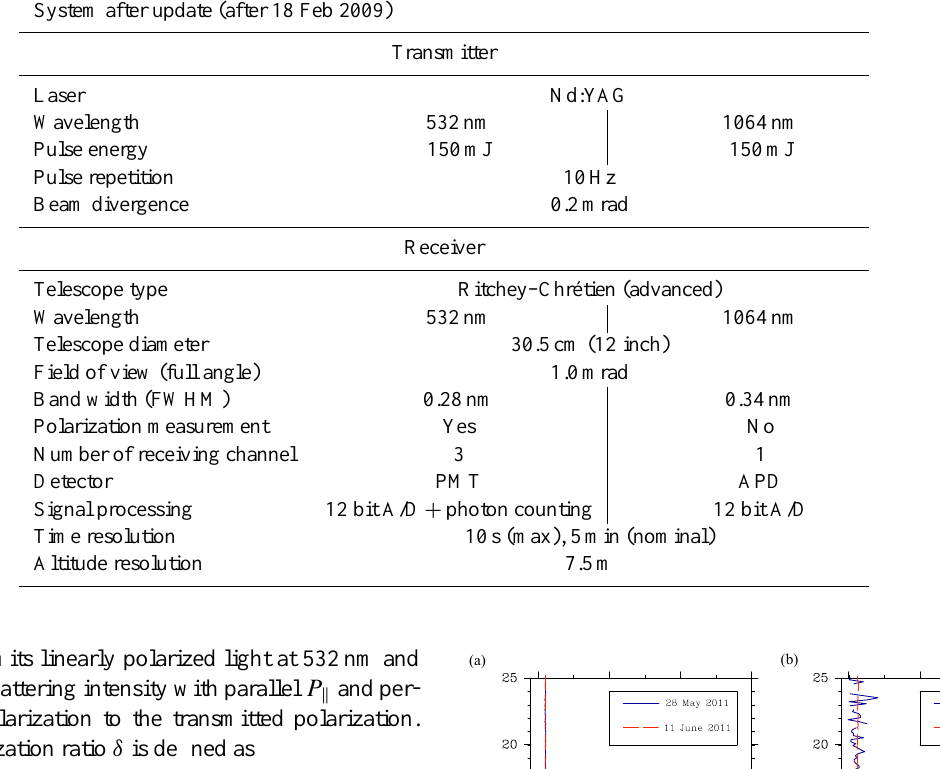
Table 1. Lidar system at Lauder, New Zealand.